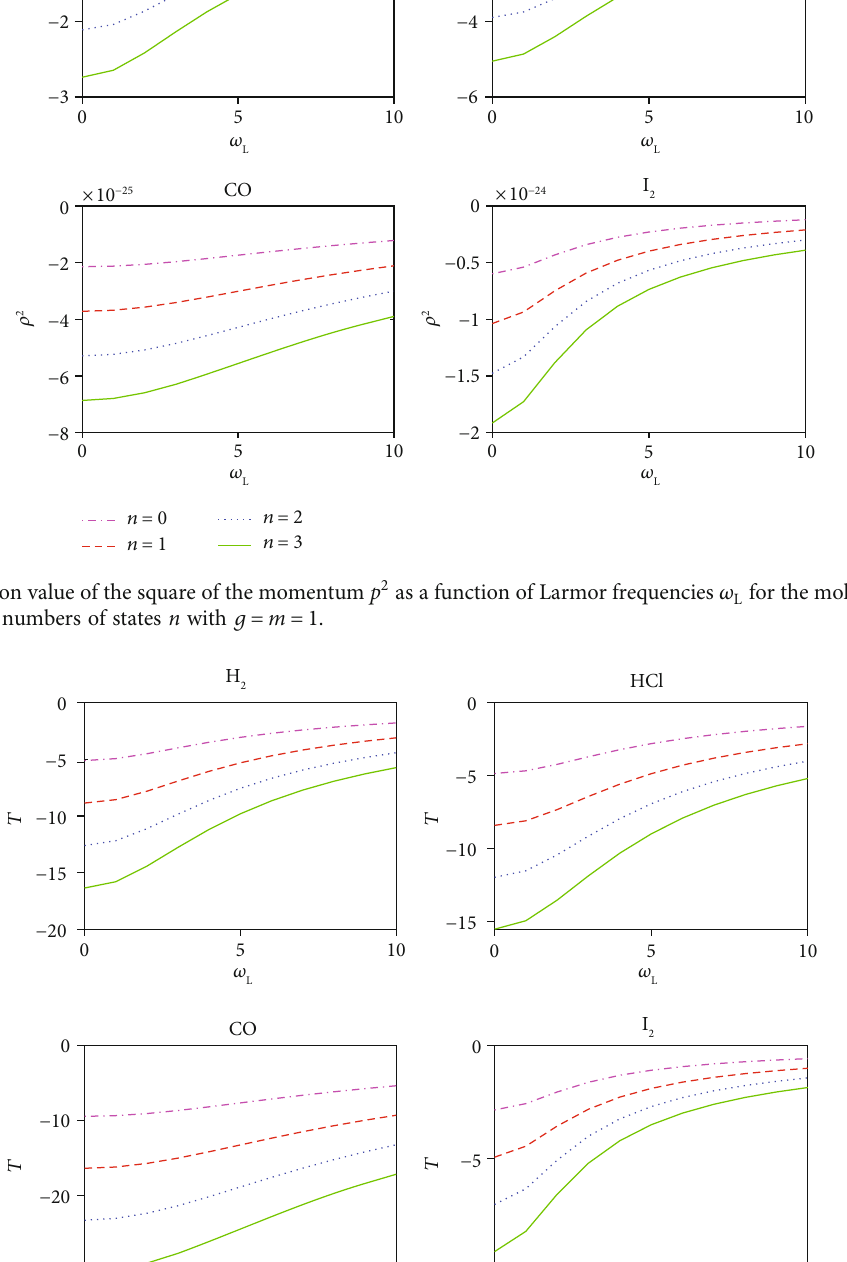
for various numbers of states n with g = m = 1 . L